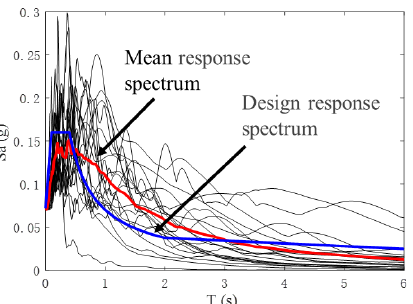
Figure 6. Response spectrum of input seismic wave.